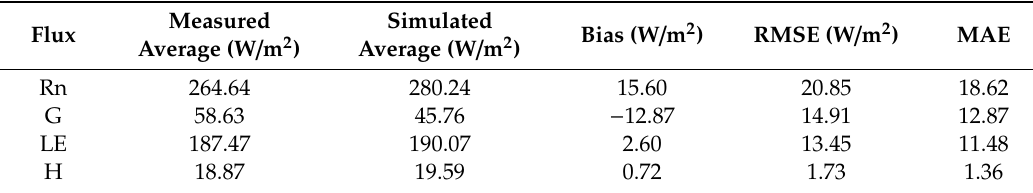
Table 2. Statistics of the novel TSEB model-derived surface energy fluxes with